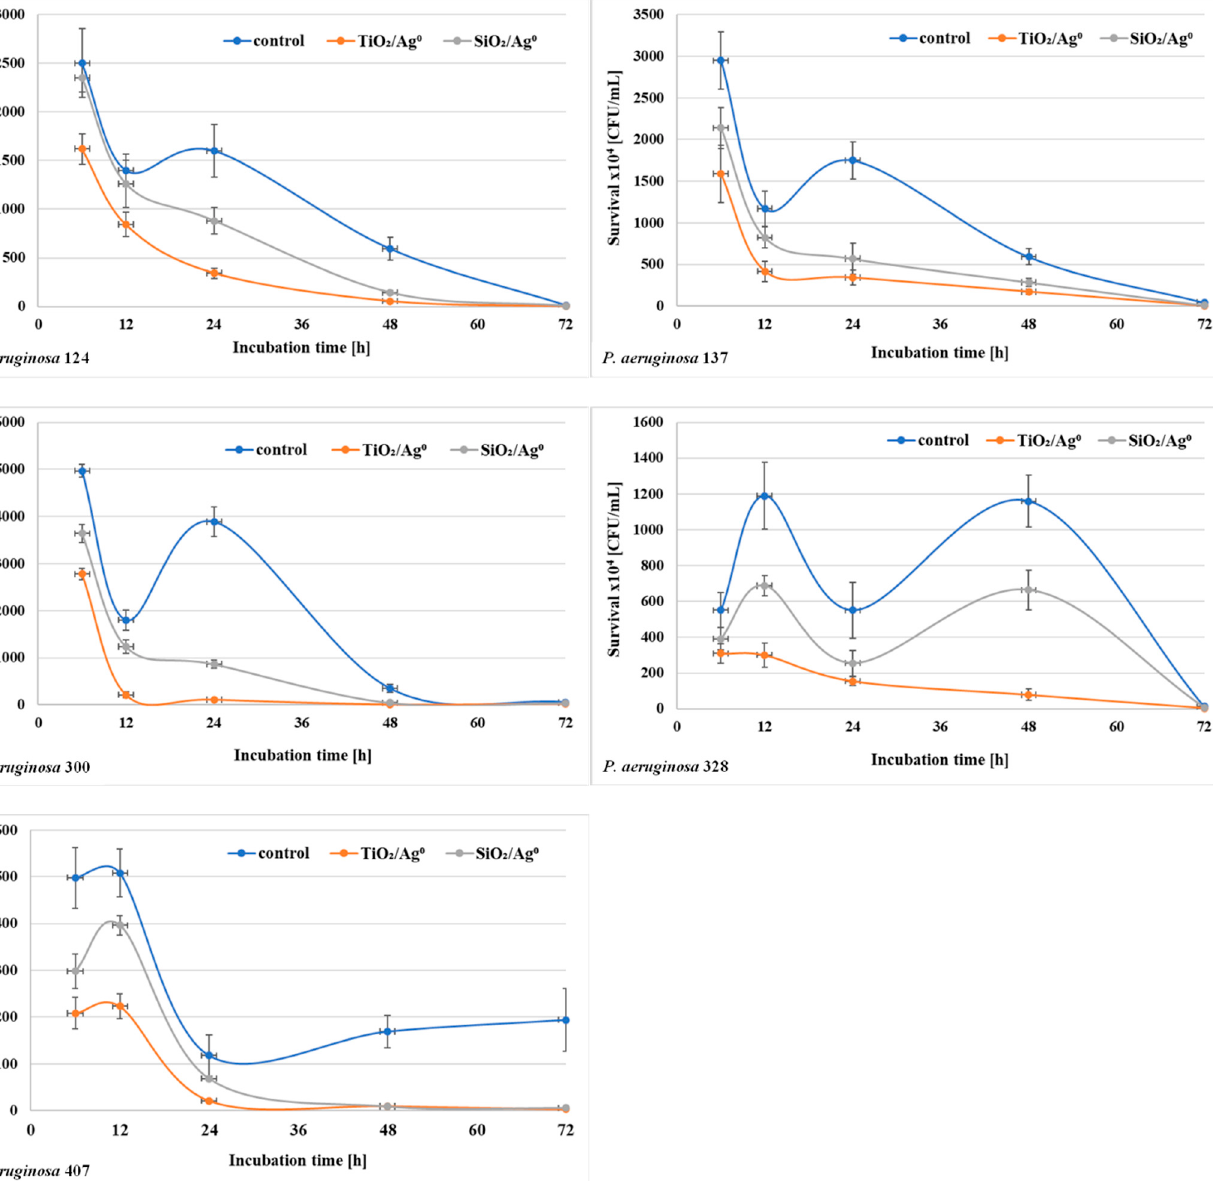
Figure 6. Effect of SiO 2 /Ag 0 and TiO 2 /Ag 0 on the survival of P. aeruginosa strains isolated from urine in biofilm mass.